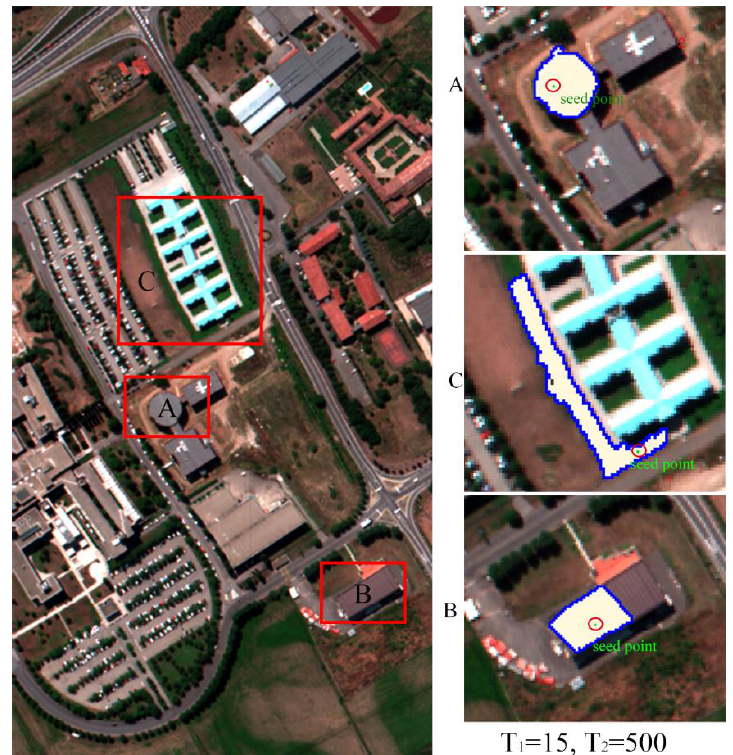
Figure 2. Examples of adaptive regions for the proposed D-AMVS. The green points inside the red circles are the central pixels of each extension, and the blue borders define the shape of the adaptive region: ( A ) and ( B ) are the examples of adaptive region when the central point in the buildings with different shape; ( C ) is the example of adaptive region when the central point in the meadows.